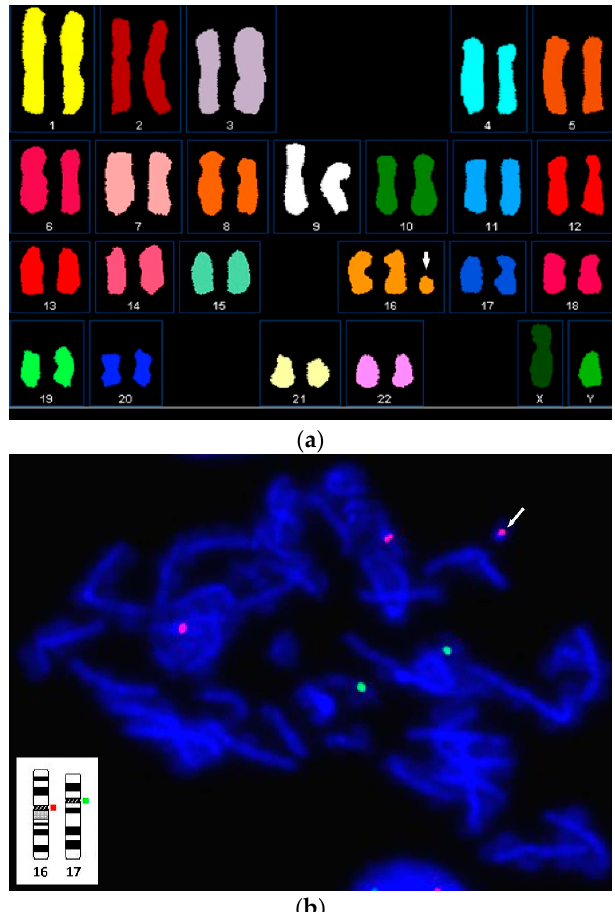
Figure 2. Molecular cytogenetic analyses of cultured amniocytes at 19 weeks of gestation: ( a ) spec- tral karyotyping (SKY) using 24-color SKY probes (Applied Spectral Imaging, Carlsbad, CA, USA) showed that the sSMC is derived from the chromosome 16 (sSMC(16)) (47,XY,+mar.ish der(16)(D16Z1+)); ( b ) metaphase fluorescence in situ hybridization (FISH) using Satellite Enumera- tion probes (Cytocell Inc. Adderbury, Oxfordshire, UK) confirmed the sSMC is of sSMC(16). Probes specific for the centromeres of chromosome 16 (D16Z2, corresponding to 16p11.1-q11.1) and 17 (D17Z1, corresponding to 17p11.1-q11.1) are labeled with red and green, respectively.